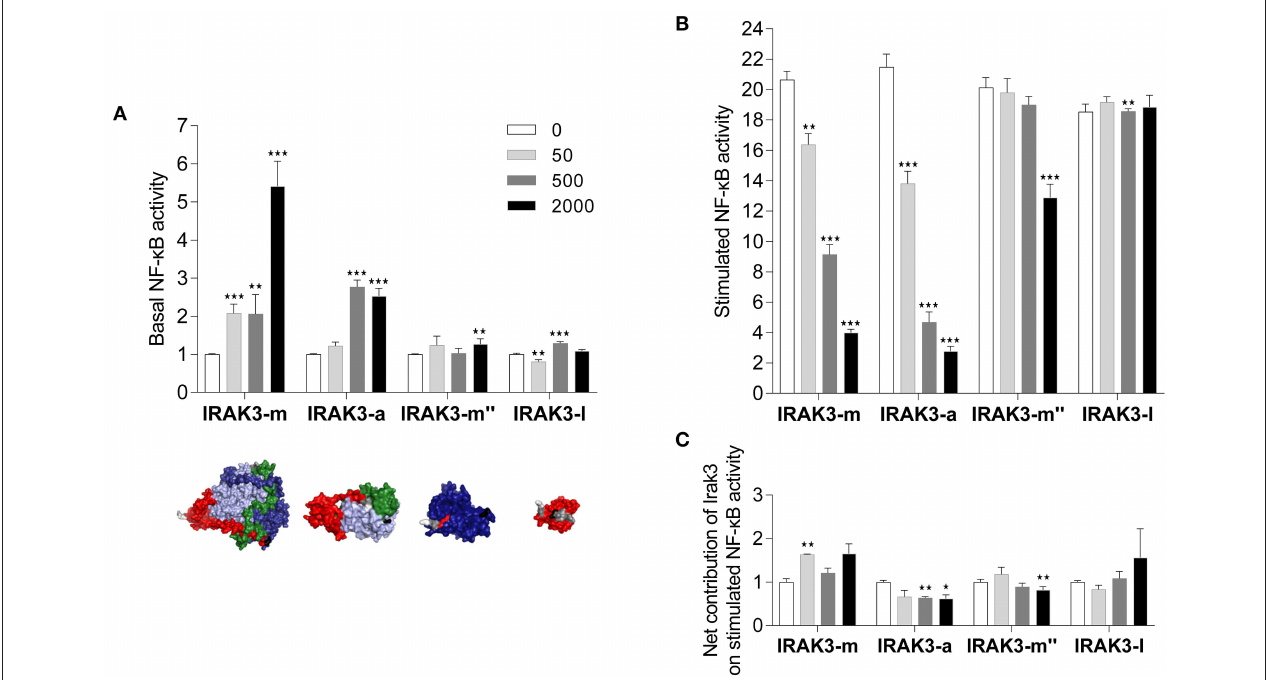
FIGURE 6 | Reporter-gene analysis assessing the influence of Irak-3 factors on NF- κ B activity in HEK-293 cells. HEK-293 cells were co-transfected with constructs expressing the bovine TLR2 and the mammalian ELAM-driven NF- κ B-luciferase reporter together with increasing amounts of the plasmids (gray-scaled columns) that express the irak3 variants m, a, m ′′ , and l. (A) Fold-change values (ordinate) of the basal luciferase activity 24h after transfection of Irak3 -encoding plasmids, relative to the control (open columns) having received the empty plasmid only and no stimulation. The tertiary structures of the transfected irak3 variants are displayed below the diagram. (B,C) Fold-change values of the luciferase activity after stimulation of TLR2 signaling with 10ng/ml Pam 2 CSK 4 and 100ng/ml FSL-1 for 24h, (B) relative to unstimulated control cells having been transfected with the same amount of the respective irak3 -encoding plasmids, (C) relative to stimulated control cells transfected with the empty plasmid. Mean values from 2 or 3 independent experiments, each assayed in triplicate, are given. Statistical significance compared with the control group was assessed using one-way ANOVA (* p < 0.05; ** p < 0.01; *** p <